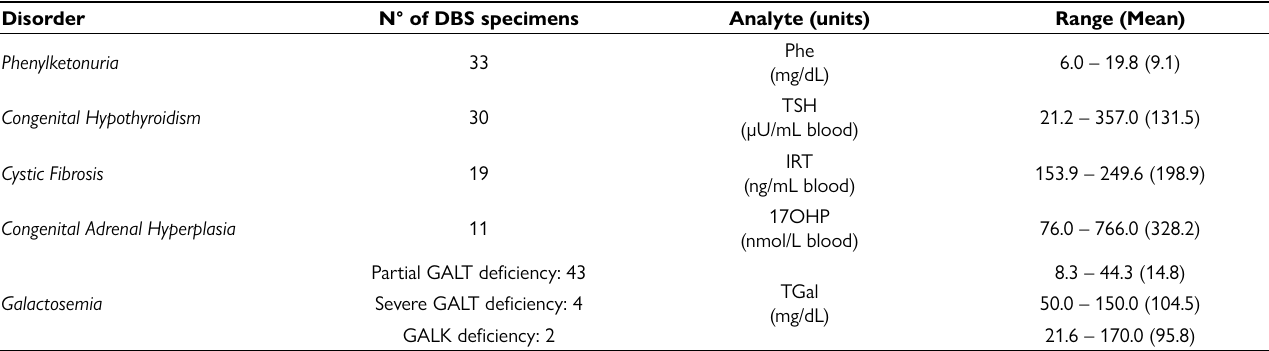
Table 3. Distribution of selected residual DBS specimens stored in freezer at -20 °C, according to the diagnosis.